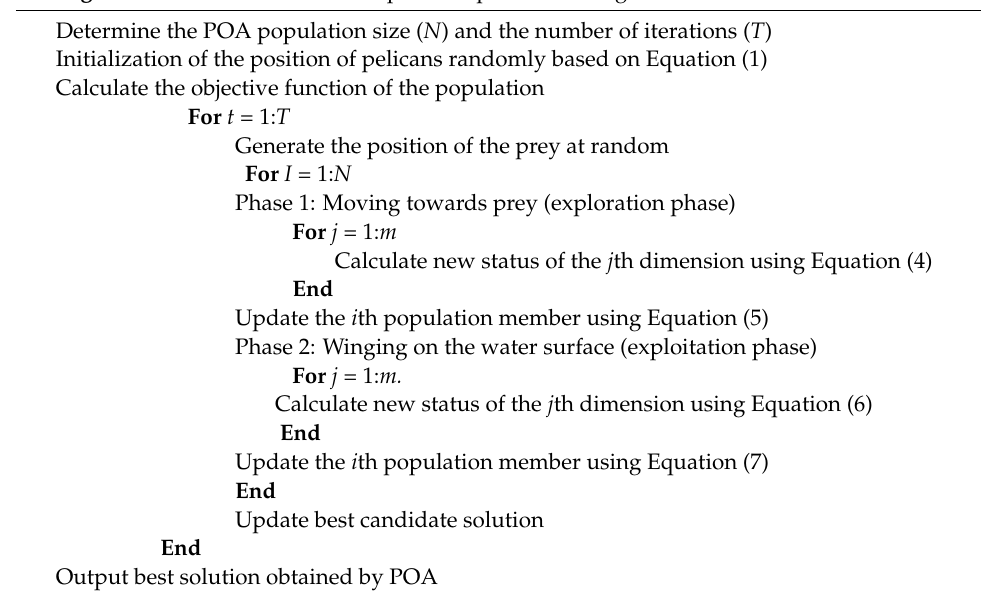
Algorithm 1: Pseudo-code of the pelican optimization